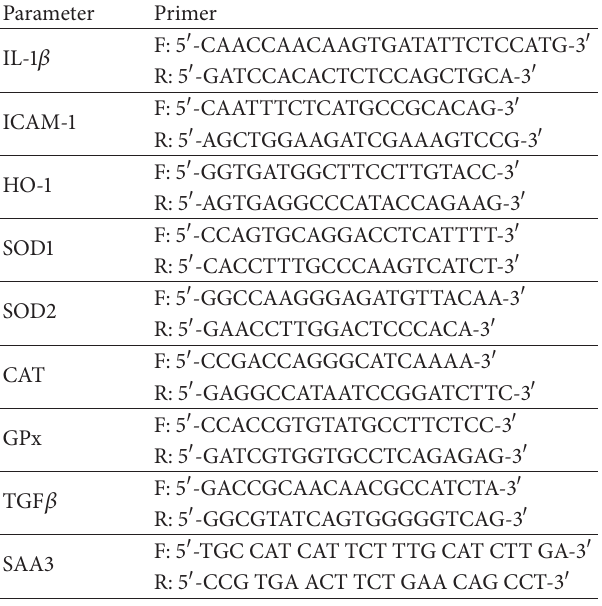
Table 1: Mouse primers used for QPCR analysis of inflammatory cytokines and oxidative stress enzyme expression in renal